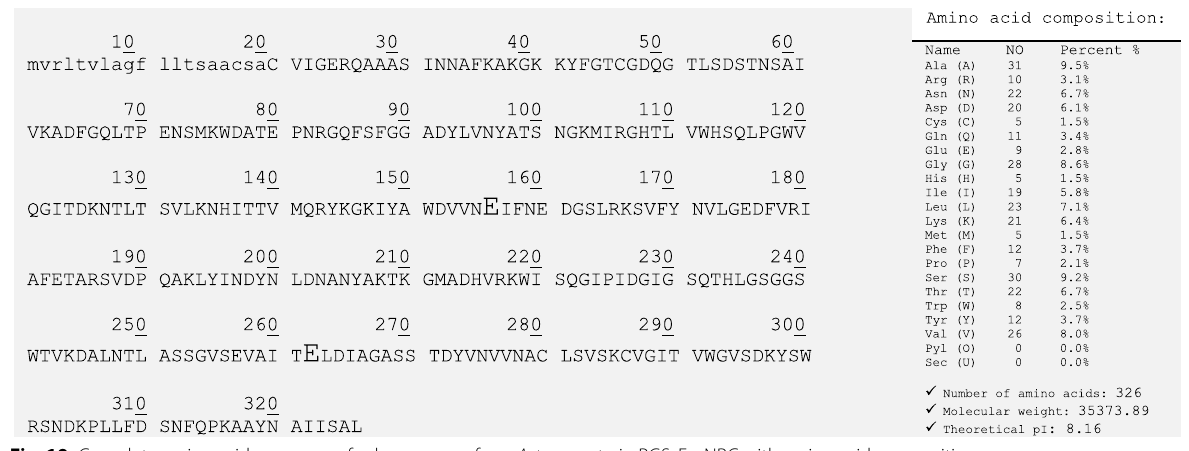
Fig. 19 Complete amino acid sequence of xylanase gene from A. terreus strain RGS. Eg‑NRC with amino acid